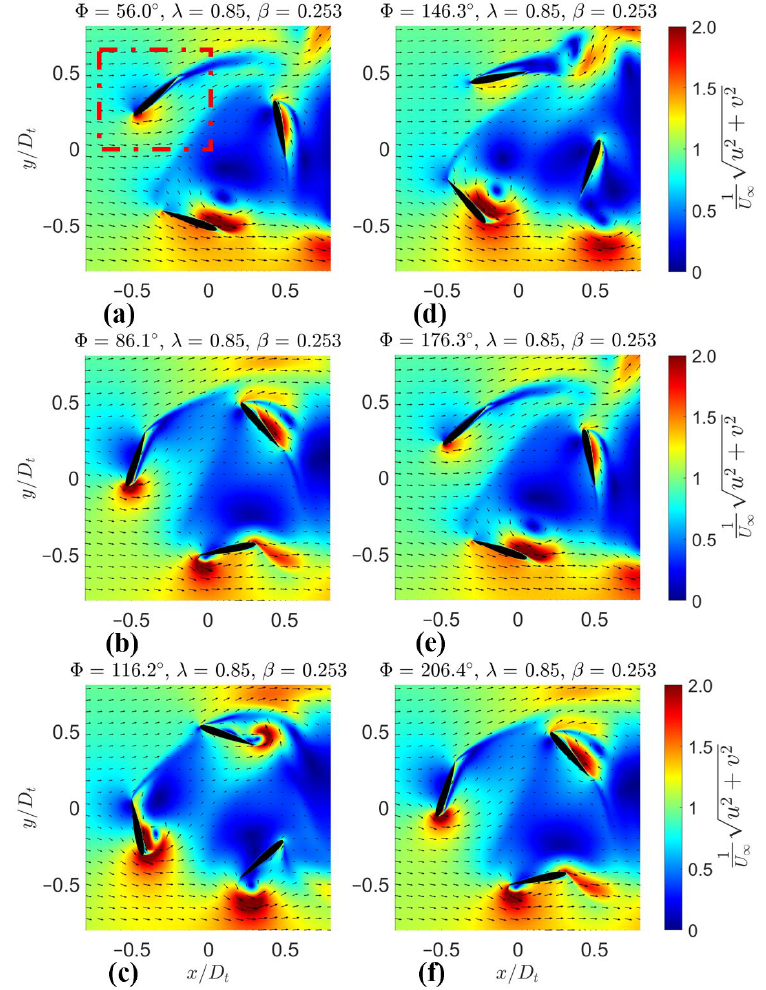
Figure 8. An example of the velocity field around the blade during its positive torque phase ( a – e ) and at an azimuthal angle after it switched into the negative torque zone ( f ). The analysis focused on the blade enclosed in the red dashed lines in ( a